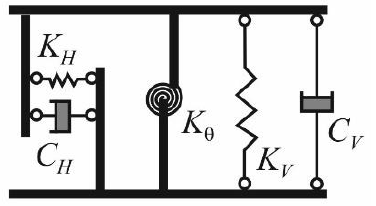
Figure 1. Three spring—two dashpot model for HDRBs.